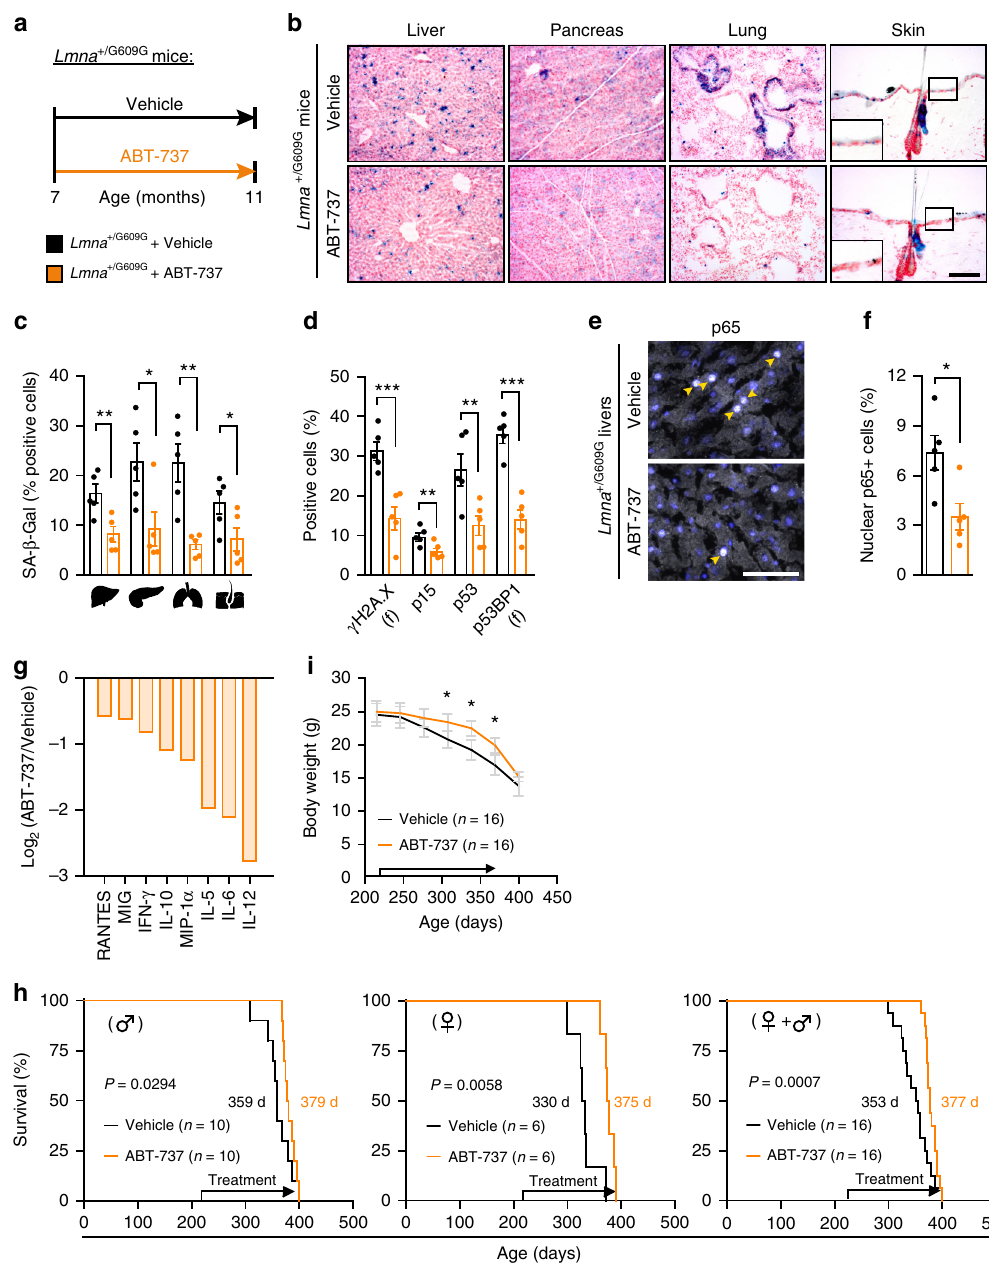
Fig. 5 Treatment with ABT-737 increases median lifespan of progeroid mice. Starting the age of 7 months ABT-737 or DMSO-based vehicle solution was administered to LMNA + /G609G mice. a Scheme of drug administration to LMNA + /G609G mice. b Representative images depicting SA- β -Gal activity